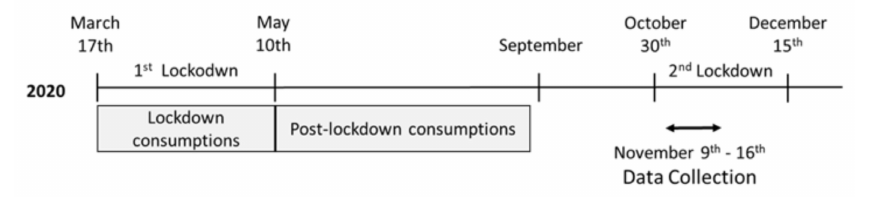
Figure 1. Timeline of lockdowns in France and data